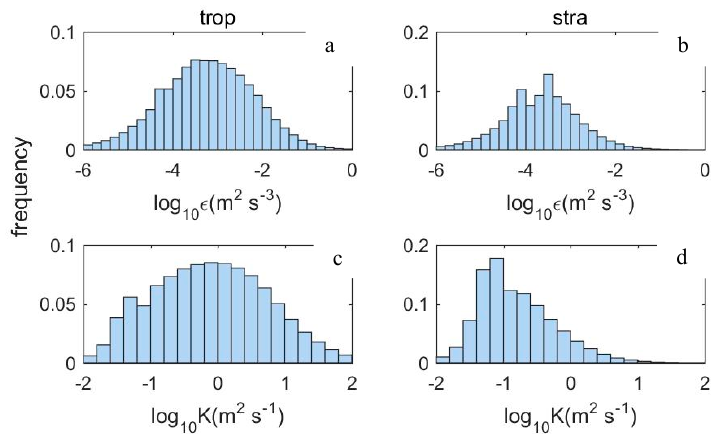
Figure 8. Histogram of the frequency distribution of ( a ) tropospheric energy dissipation rate, ( b ) stratospheric energy dissipation rate, ( c ) tropospheric diffusion coefficient, ( d ) stratospheric diffusion coefficient.